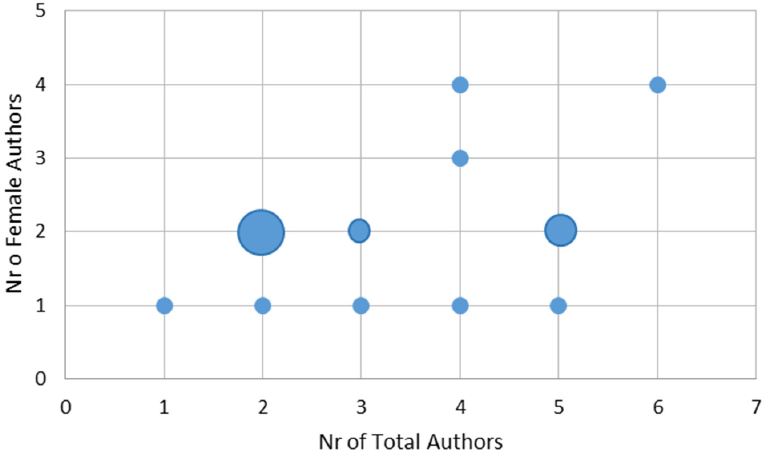
Figure 5. Relationship between total number of authors of the paper and the number of female authors. Size of the circle represents the number of papers at each point.